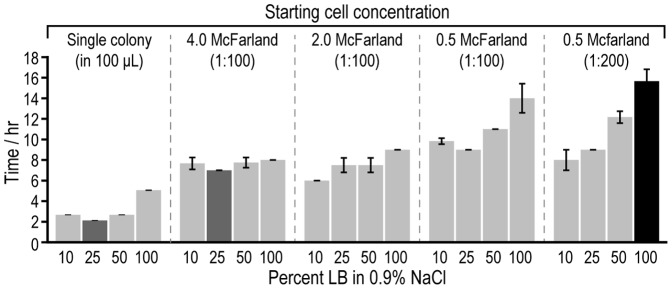
Optimization of buffer conditions and cell concentrations on A. baumannii identification.The plot depicts the average time to A. baumannii identification using different starting concentrations of cells and loading the BacChip with media formulations consisting of LB diluted in saline. We ran assays with starting cell concentrations of 4.0 McF, 2.0 McF, and 0.5 McF. Parentheses indicate the consequent dilution into the loading media. We also tested single colonies from LB agar plates grown overnight at 37°C that were suspended in 100 µL of loading solution as a starting cell concentration. Based on our sampling time points, our temporal resolution for detection was ∼1 h. The colored bars indicate the most rapid (dark gray) and slowest conditions (black). Error bars indicate the standard deviation of the mean (n≥3).